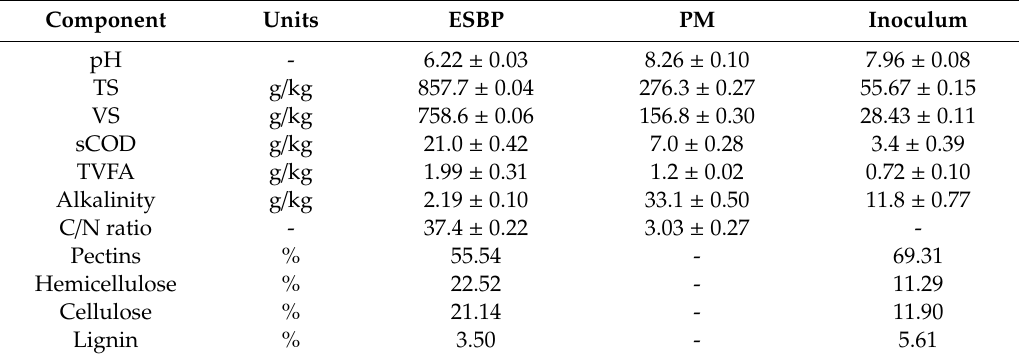
Table 1. Physicochemical characteristics of the substrates and inoculum.